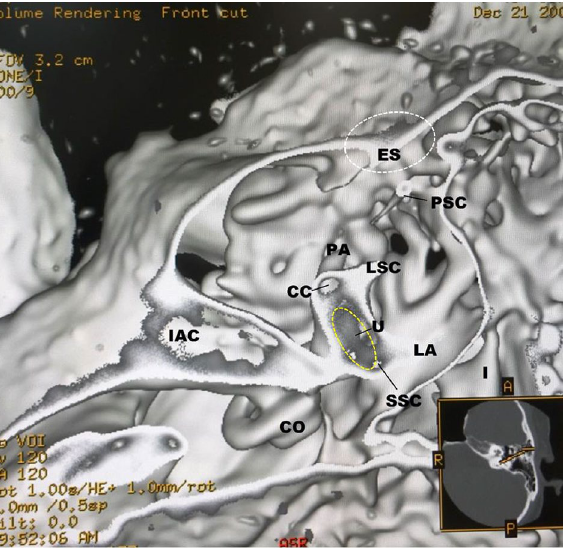
Figure 2. A normal case in a 48-year-old female. From the superior view of the utricular macula, the portion of the utricular macula (yellow dotted oval) lies approximately in the plane of the lateral ampulla and shows a gray peanut-shaped oval. The width and length measured in the 3D image were 1.8 and 2.6 mm, respectively. The endolymphatic sac (white dotted oval) shows a gray triangle. U utricular macula (yellow dotted oval), LA lateral ampulla, PA posterior ampulla, PSC posterior semicircular canal, LSC lateral semicircular canal, SSC superior semicircular canal, CC common crus, ES endolymphatic sac (white dotted oval), CO cochlea, I incus, IAC internal auditory canal.